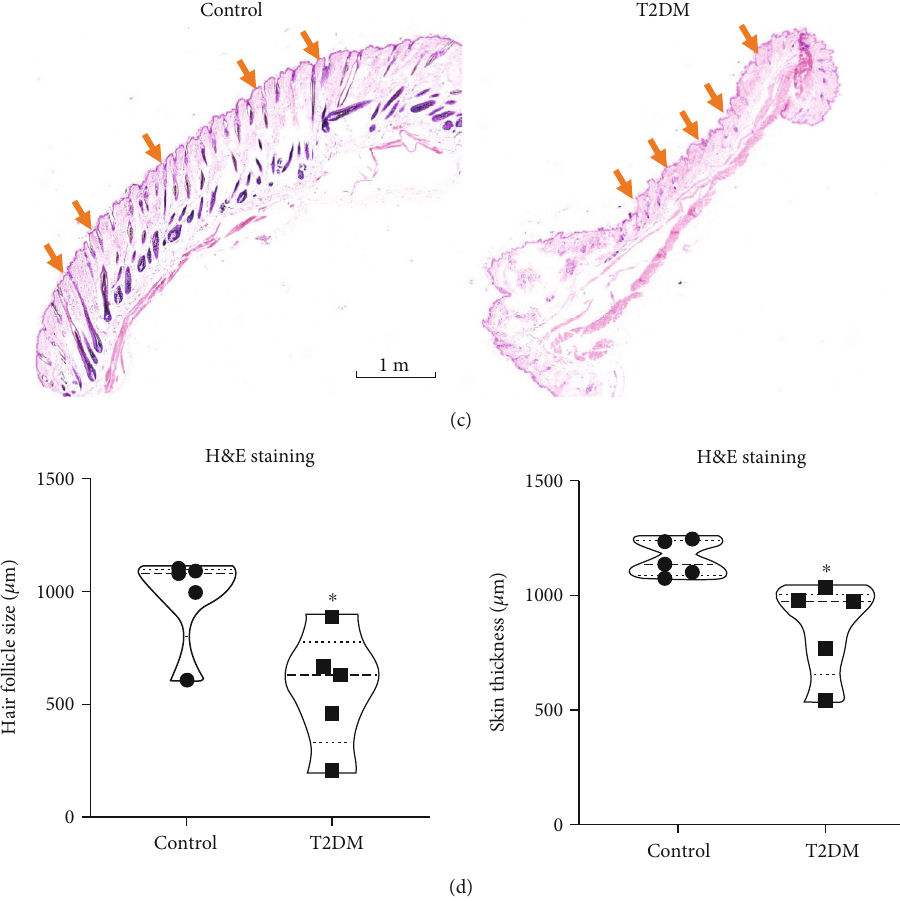
Figure 1: T2DM inhibits hair cycling and reduces skin thickness. (a) Representative photo of hair regrowth on the back of mice. S: signi fi cant; A: alteration; N: no change. (b) 40% and 60% of control mice show signi fi cant hair regrowth and hair follicle alteration, respectively. 20% and 40% of T2DM mice show signi fi cant hair regrowth and hair follicle alteration, respectively. The other 40% of mice have no change. (c) Representative photos of hair follicles. Orange arrows direct the hair follicles. (d) T2DM signi fi cantly decreased hair follicle size (control 975 ± 210 vs. T2DM 568 : 8 ± 254 : 3 μ m, P = 0 : 0249 , n = 5 ) and skin thickness (control 1159 ± 77 : 69 vs. T2DM 859 : 8 ± 204 : 4 μ m, P = 0 : 0155 , n = 5 ). ∗ P < 0 : 05